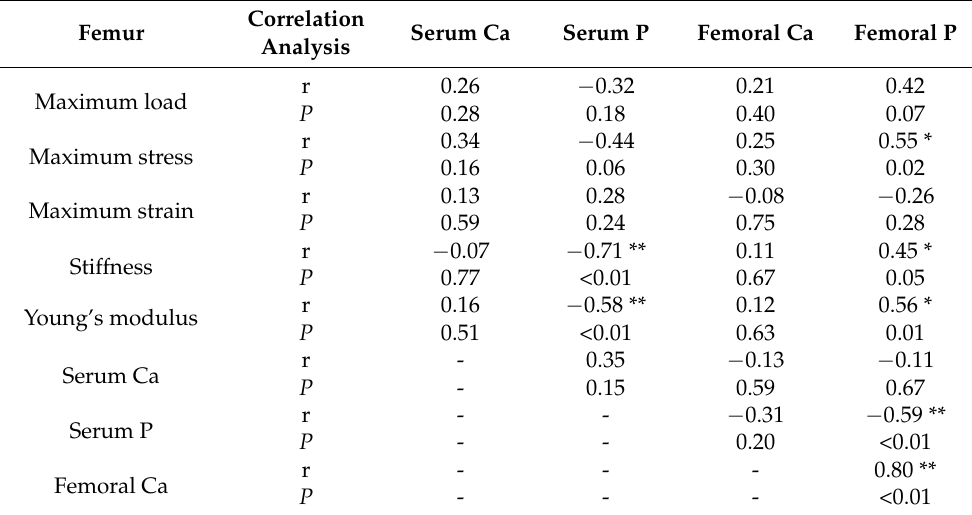
Table 7. The correlation between bone P and Ca contents as well as serum P and Ca levels and bone physical parameters in laying